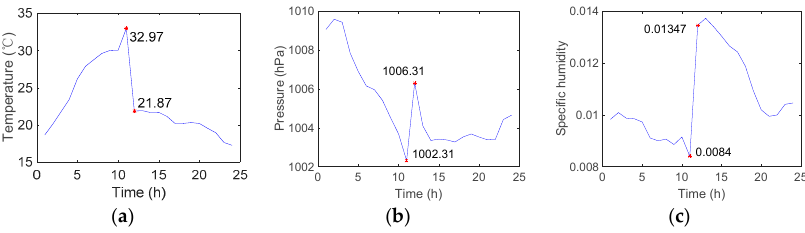
Figure 10. Temperature ( a ); pressure ( b ); and specific humidity ( c ) conditions for location (50.7° N, 75.6° E) on 11 June 2016.